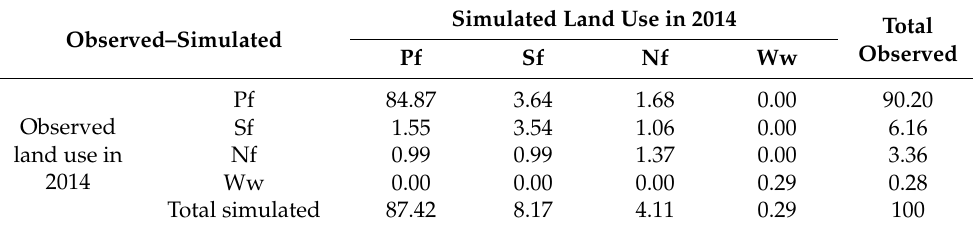
Table 7. Comparison between observed and simulated land use.